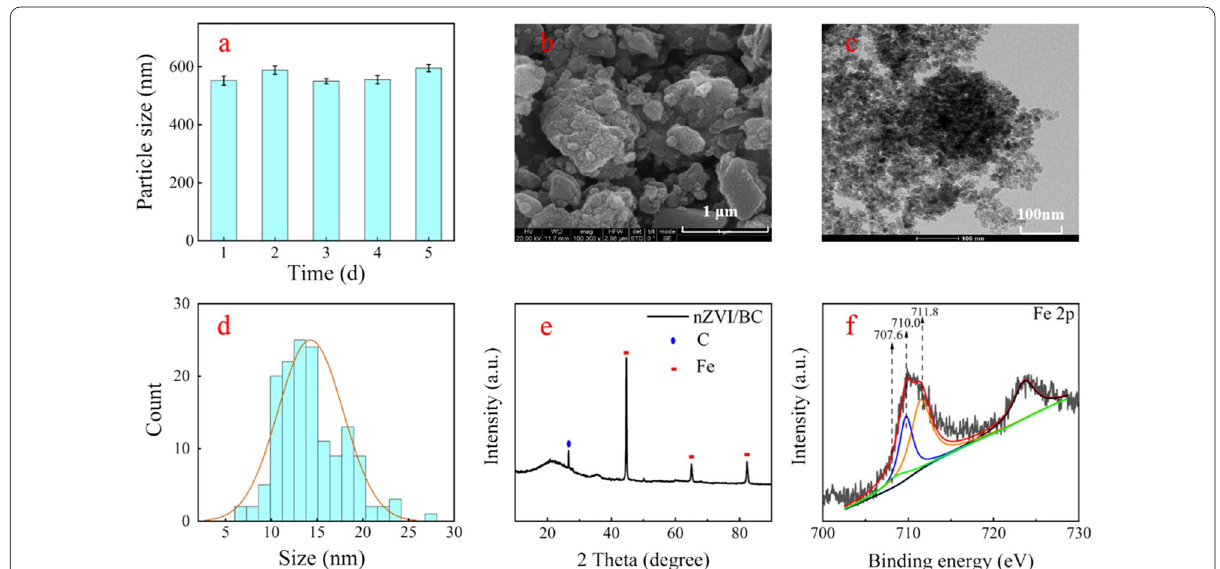
Fig. 2 Characteristics of biochar supported nano zero-valent iron (nZVI/BC): a Hydration particle size at different time of ball milling; b SEM micrographs; c TEM micrographs; d Particle size distribution; e XRD pattern; f XPS